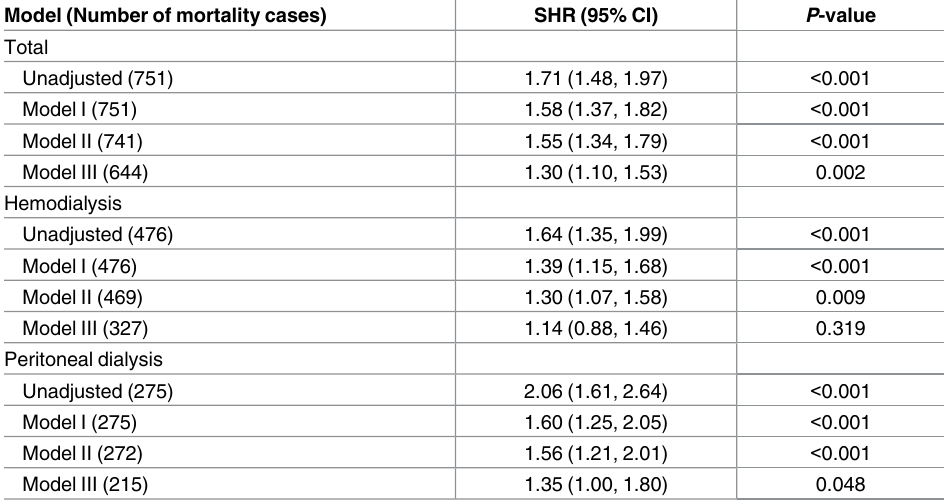
Table 3. Competing risk regression analysesof mortality in patients with serum potassium < 4.5 mmol/L according to dialysis modality. Model (Number of mortality